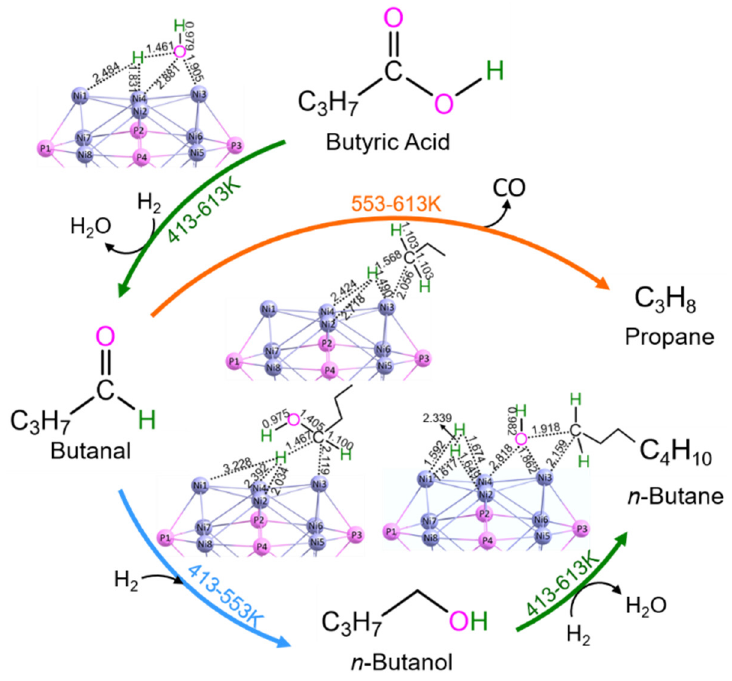
Figure 11. The main reaction pathways for the deoxygenation of butyric acid over Ni 12 P 5 cluster.